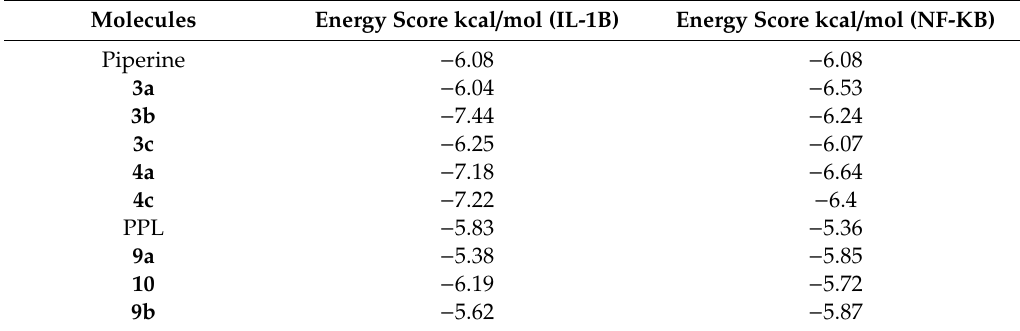
Table 2. Binding energy scores obtained for the proteins IL-1 β and NF- κ B with Piperine, PPL and